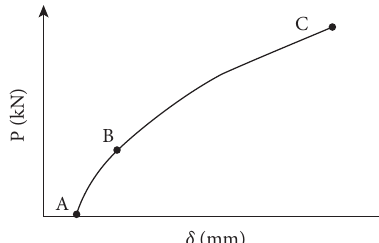
Figure 4: The typical load-deformation curve of damage strengthened beam.